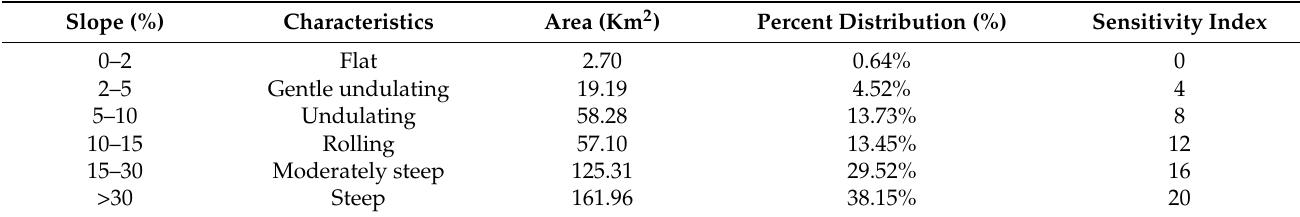
Table 1. Slope classes as per FAO